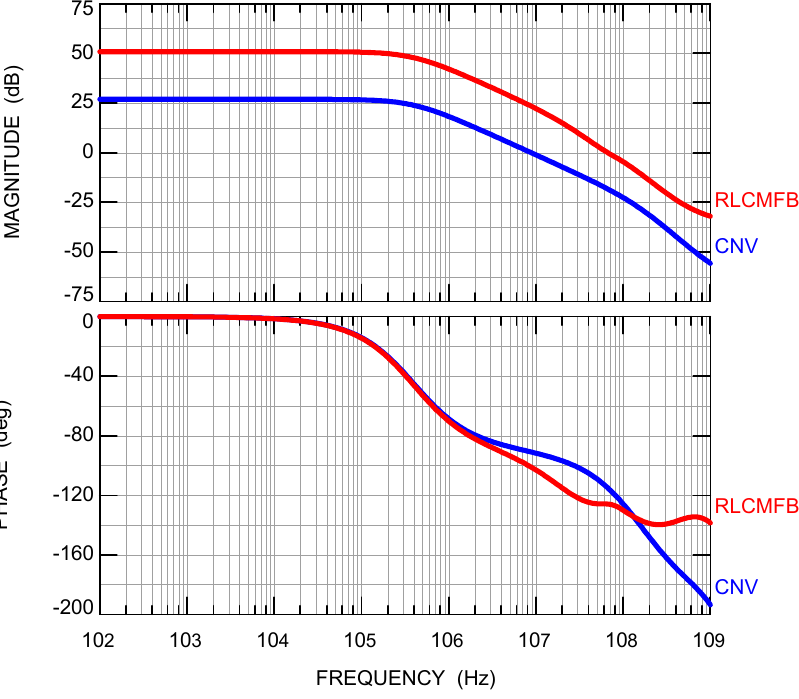
Figure 4. Open loop response AC responses of circuits of Figure 3.